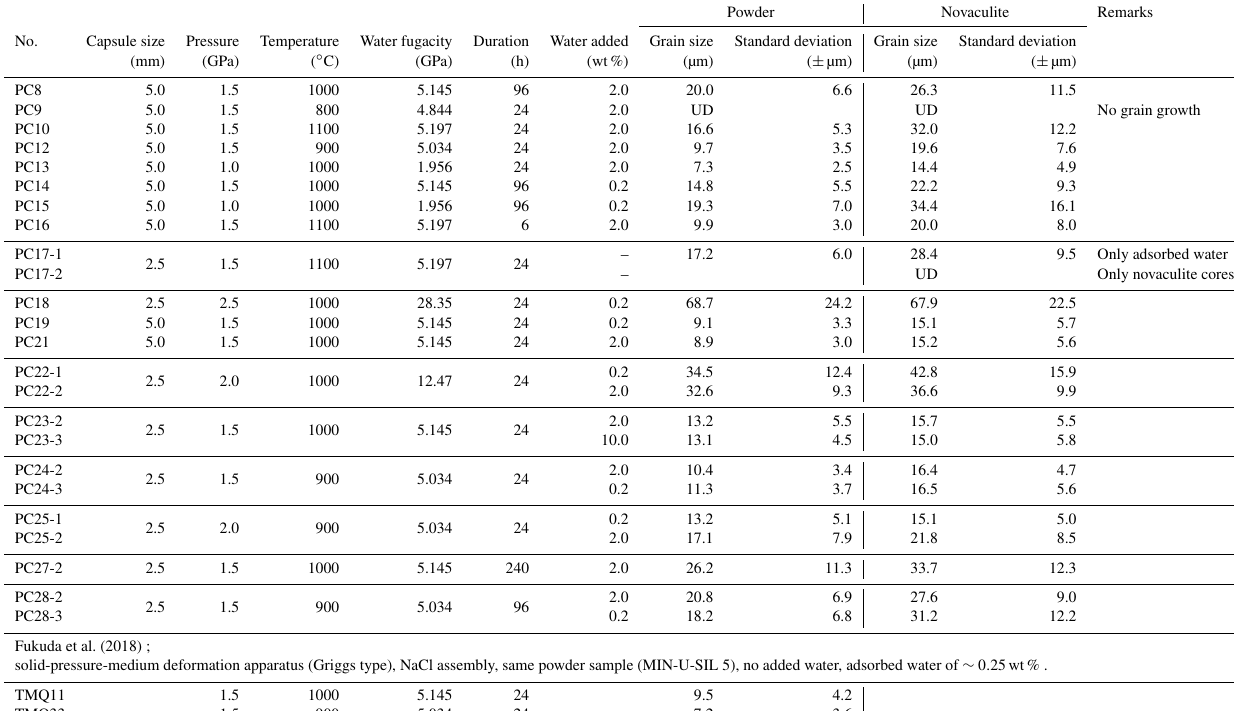
Table 1. Experimental conditions and grain sizes determined.